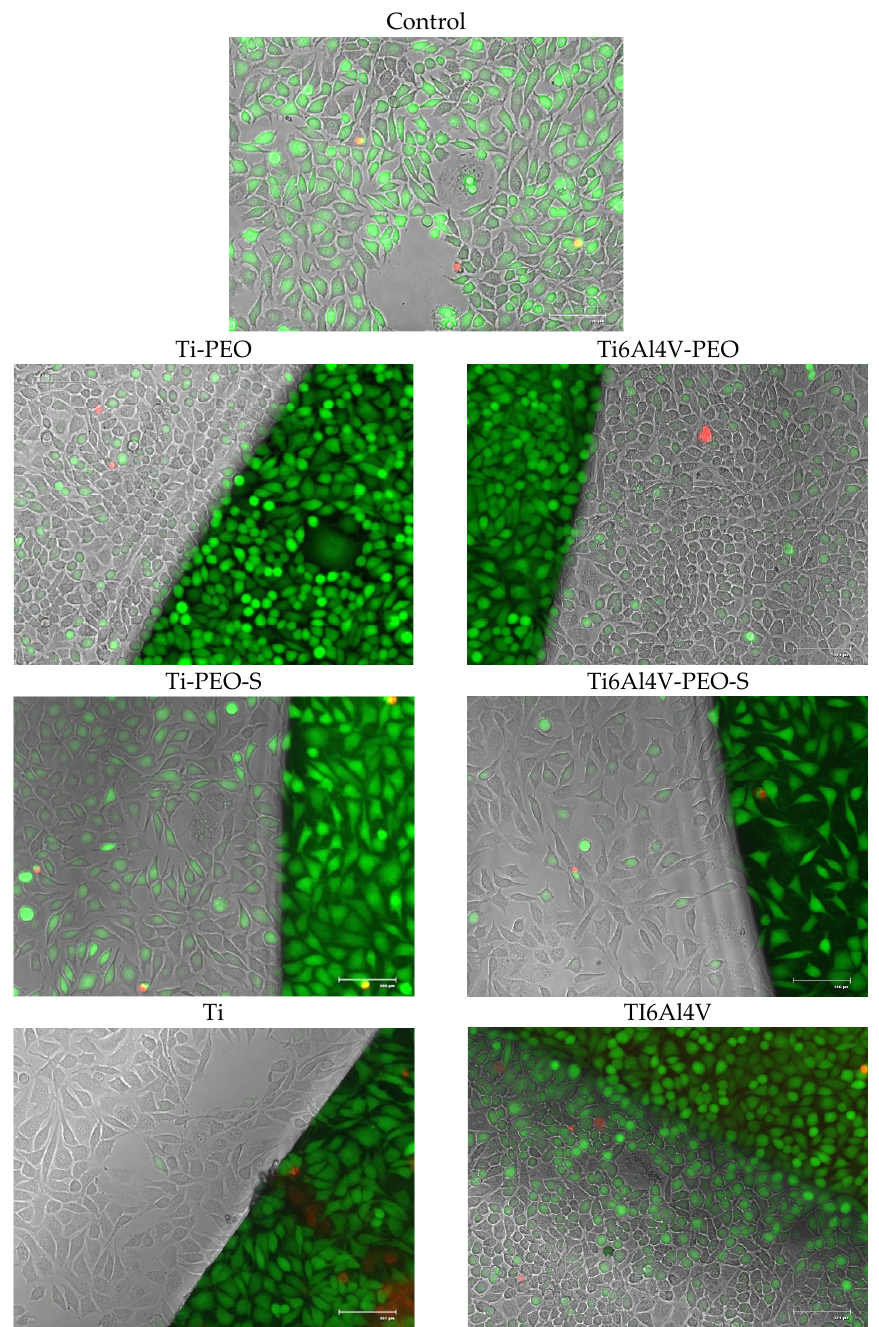
Figure 4. Co ‐ culture of L929 cells and test materials. Live dead (green/red) staining under 20× objective magnification, FLOID microscope. Microphotographs show cells growing close to and directly under the material.